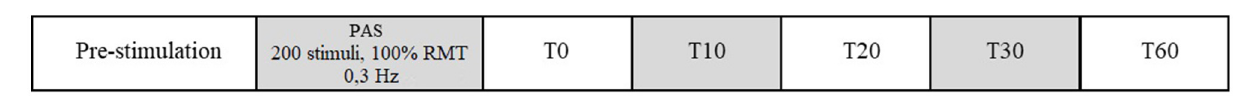
FIGURE 1 | The standard paired associative stimulation (PAS) session